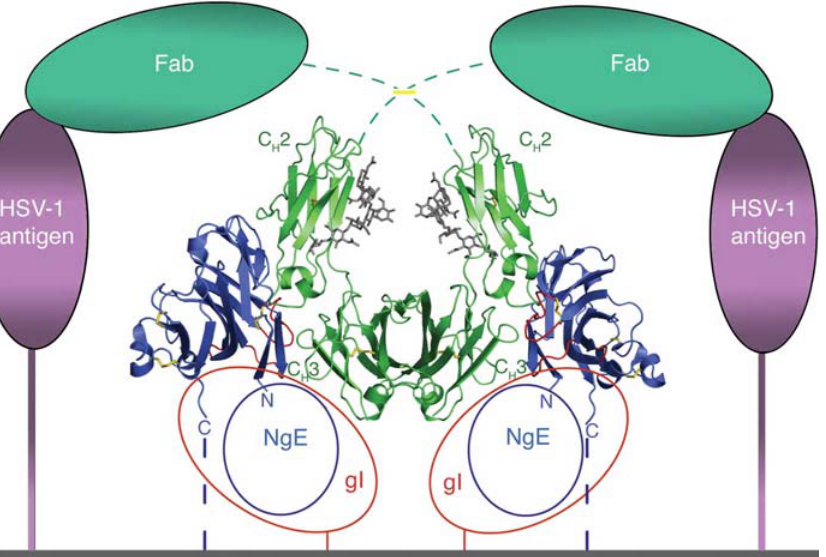
Figure 5. Model for gE-gI–Mediated Antibody Bipolar Bridging on the Cell Membrane A ribbon diagram of the CgE/Fc portion of the gE-gI/Fc structure is shown with the approximate positions of the gI chain (red open oval) and NgE domain (blue open oval) shown schematically. The predicted position of the cell membrane (see text) is indicated by a gray line. The upright position of the Fc dimer suggests that the hinge region (green dashed line) and Fab arms (green ovals) of an intact antibody are located above gE-gI, where the Fab combining sites could bind to a viral antigen (purple ovals) tethered to the same membrane as gE-gI. DOI: